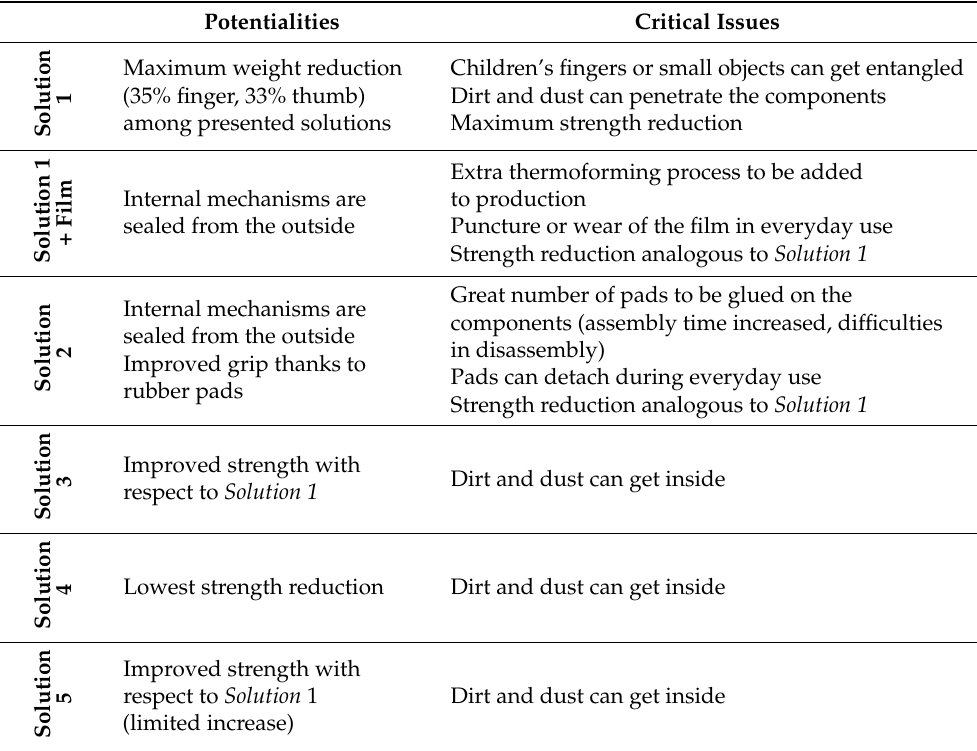
Table 1. Advantages and disadvantages of each novel-designed solution, in terms of mechanical, geometrical features, and related